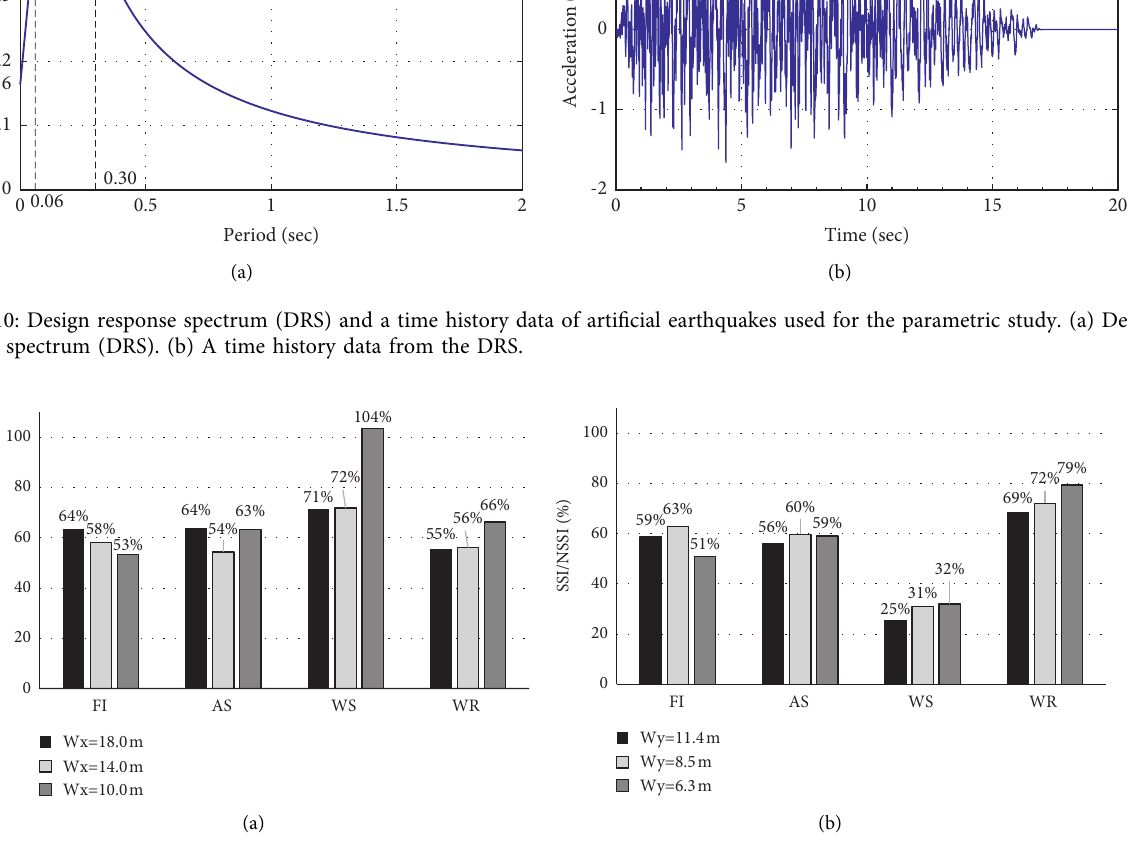
Figure 11: Ratio (SSI/NSSI) of base shear values according to the width change with different soil conditions in each direction. (a) EW direction. (b) NS direction.